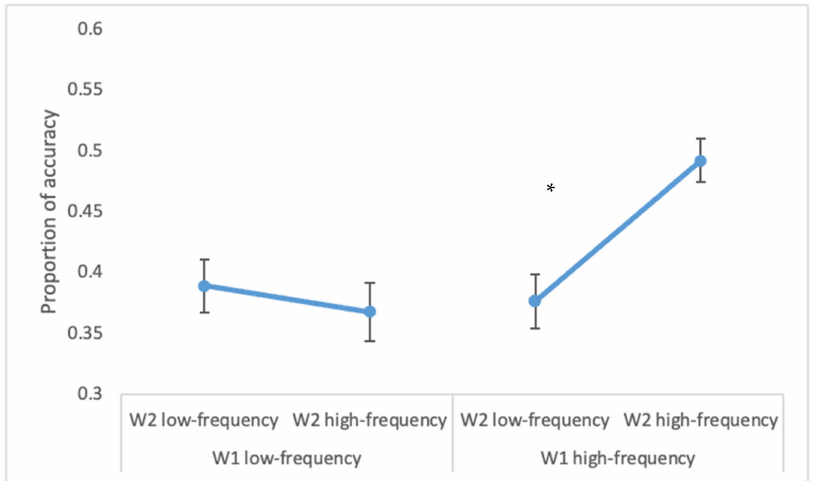
Figure 3. Experiment 2. Accuracy on W2 is reported in terms of the statistically significant interaction W1 frequency × W2 frequency. Bars represent standard errors. The asterisk (*) indicates statistically significant